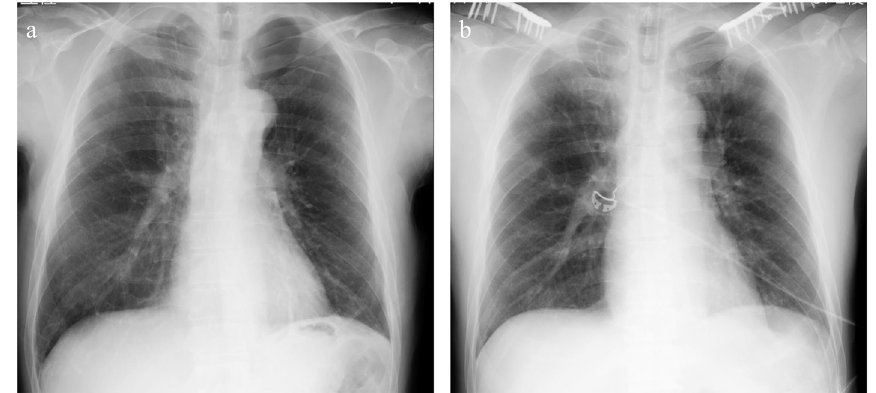
Fig. 2 a Chest radiograph image was taken 2 days after being injured, revealing bilateral midshaft clavicle fractures and left pneumothorax. b Chest radiograph image taken immediately after surgery, showing bilateral repaired clavicle